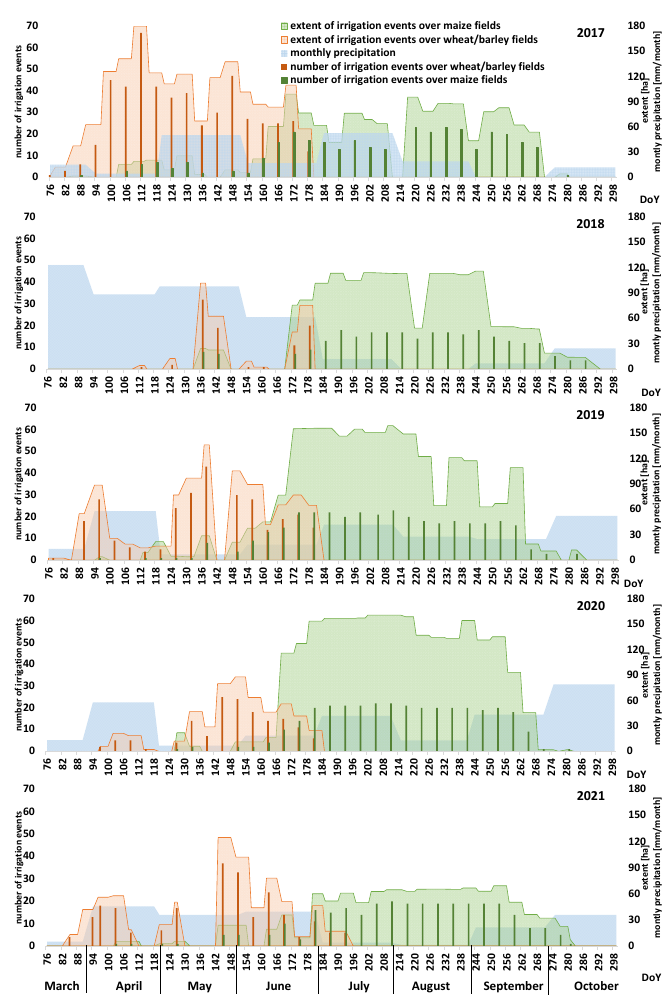
Figure 4. Number of irrigation events registered over the wheat and barley (red) and maize (green) fields irrigated 5 to 0 days before the S ‐ 1 passages from 2017 to 2021. Red and green shaded areas represent the extent of the irrigated fields. The monthly precipitation rate is also reported.